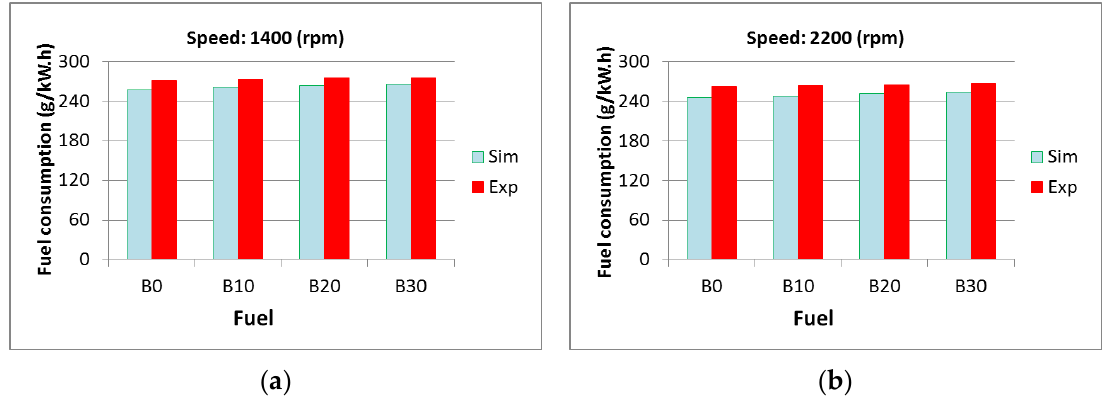
Figure 5. Comparisons between simulation results and experimental of fuel consumption. ( a ) Speed at 1400(rpm); ( b ) Speed at 2200(rpm).